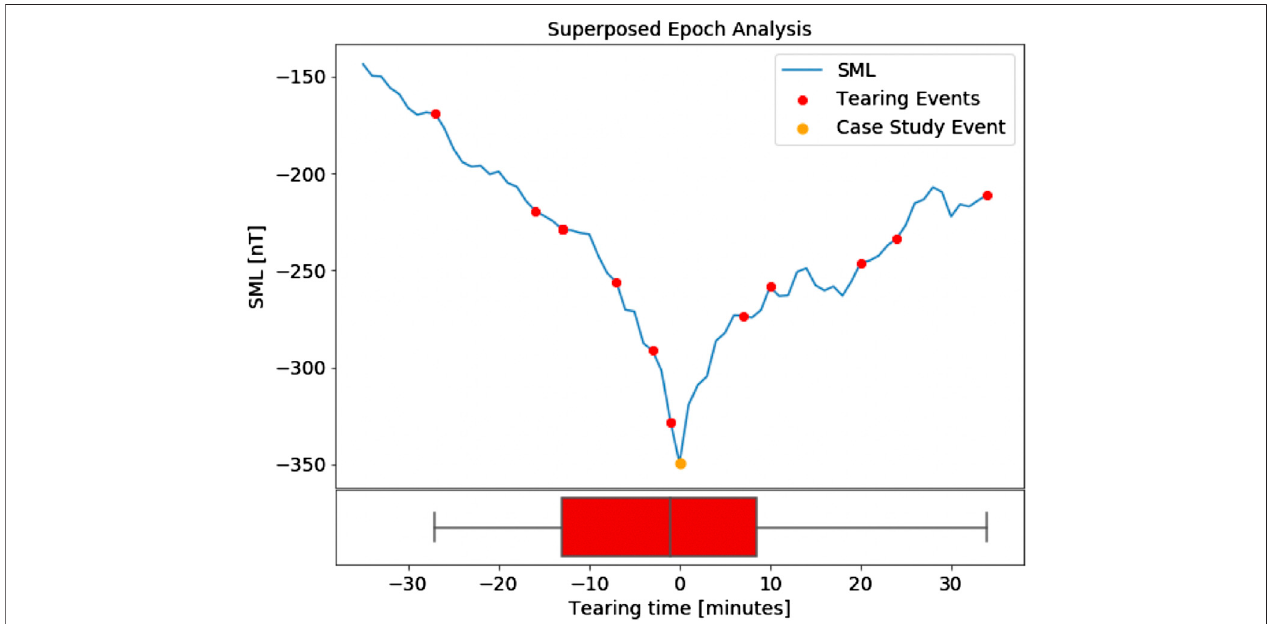
FIGURE 7 | Superposed epoch analysis of SML relating tearing to substorms. The spread of tearing times for all 15 events compared to the superposed epoch analysis of SML measurements across each of the 15 events. The blue curve is calculated by averaging the SML peak around each of the 15 tearing events, while the location of the red dots represents the relative timings of each particular tearing event in comparison to the its associated peak in SML. The box plot underneath summarises the distribution of tearing event timings in comparison to the peak in SML. The vertical lines of the red box show the lower quartile, mean, and upper quartile of the relative times, while the two longest lines show the earliest and latest tearing